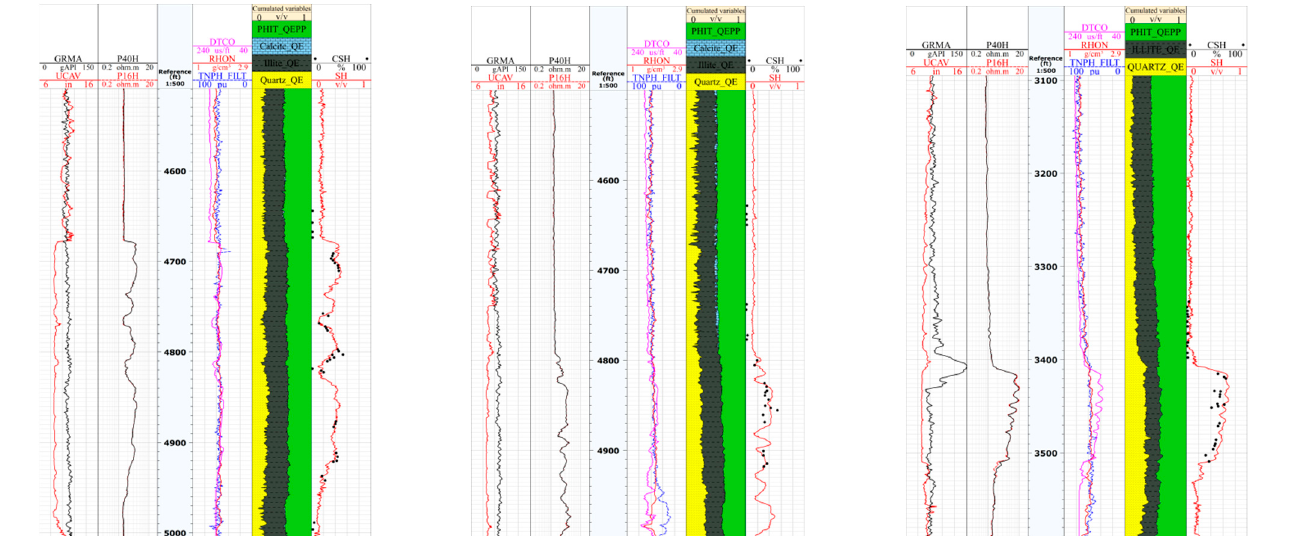
Figure 8. Archie saturation model and core data in Wells W1, W2, and W4.